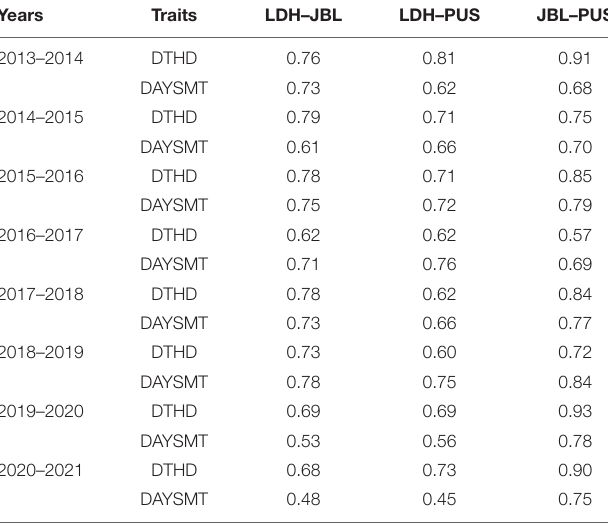
TABLE 3 | Genetic correlations between locations for days to heading (DH) and days to maturity (DM) from 2014 to